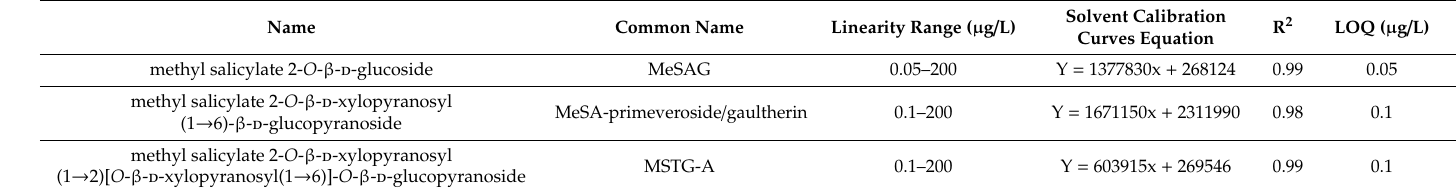
Table 4. Quantification